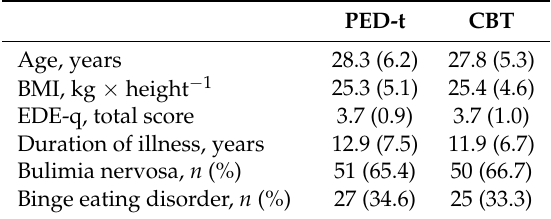
Table 2. Demographic description of participants in therapy groups. Results are mean